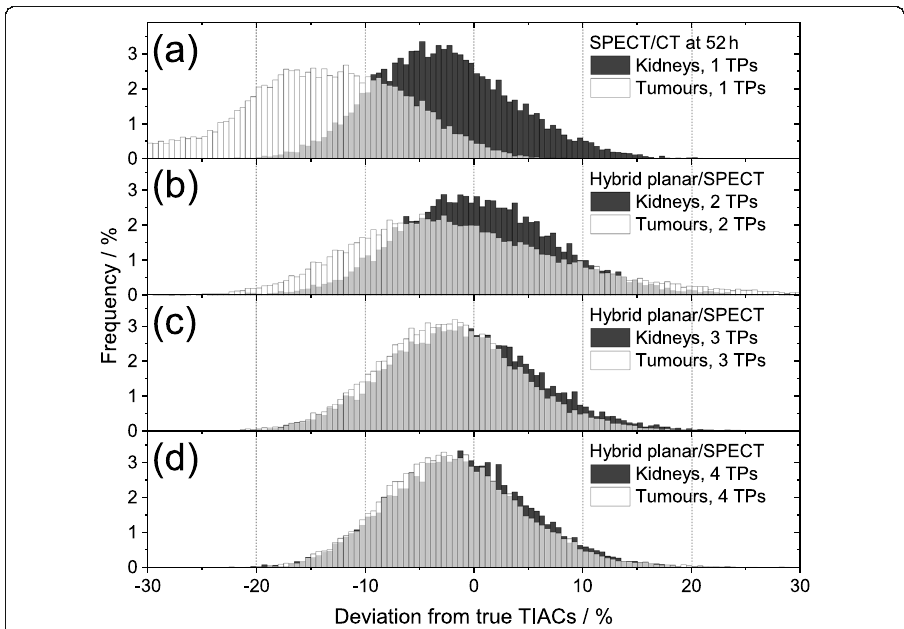
Fig. 2 Comparison of the frequency distribution of the deviations between the simulated TIACs and the ground truths using a the method with one SPECT/CT at 52 h and the hybrid planar/SPECT method with optimal sampling schedules comprising b two time points (TPs), c three TPs and d four TPs (Table 1). The kidneys (dark grey) and the tumours (white) of all 13 patients were considered. The systematic error of the simulated activity values based on planar images was assumed to contribute 50% to the total